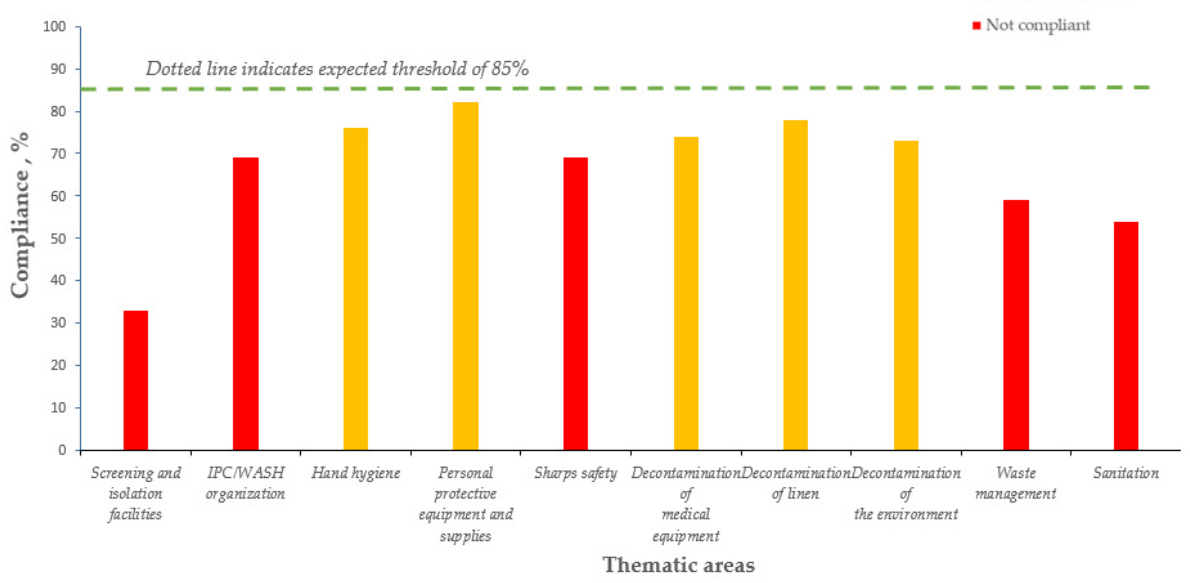
Figure 4. Average yearly IPC/WASH compliance (average of quarterly scores for the year, three quarters assessed) in the 10 thematic areas, Maternal and Child Health Posts, Kenema district, Sierra Leone 2018.